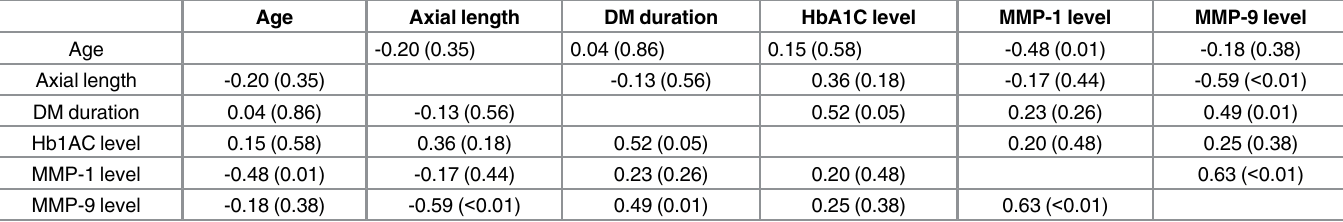
Table 2. The r-values (the rho values) derived by Spearman ’ s rank correlation (p-values,